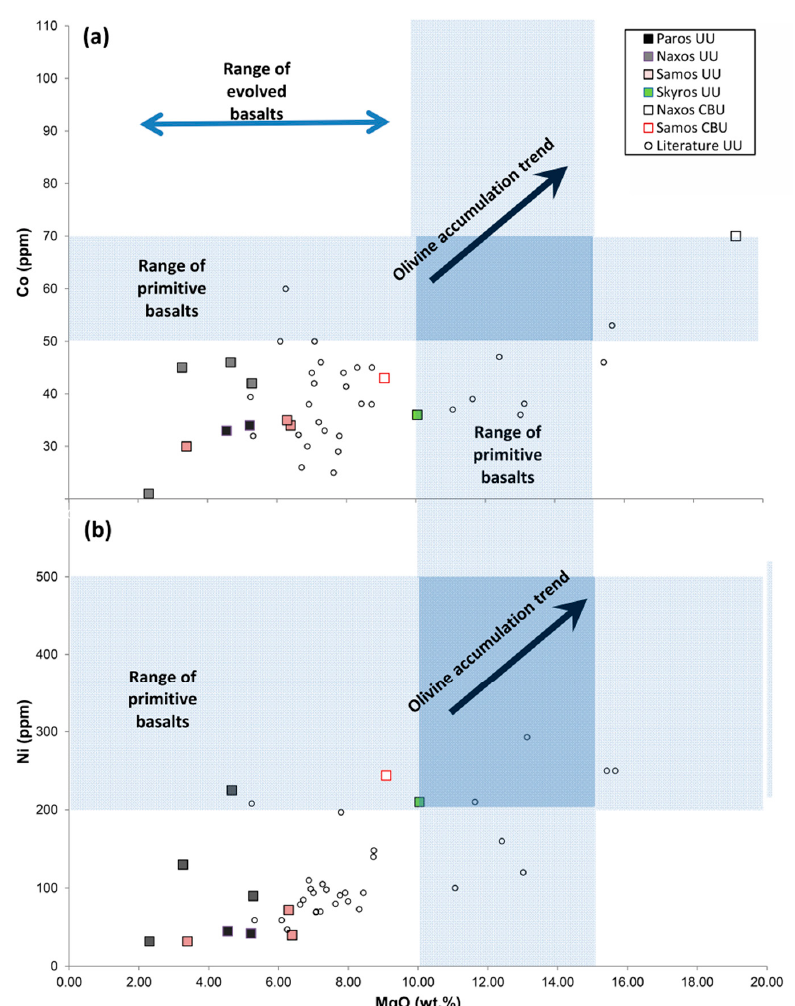
Figure 4. ( a ) MgO vs. Co and ( b ) MgO vs. Ni plot of Aegean metabasites. Upper Unit (UU) ophiolitic metabasites from the literature are also plotted: Ikaria ophiolitic mélange [10]; Tinos ophiolitic upper unit [15] (Mt. Tsiknias). Range expected for magmas in equilibrium with their mantle source: Ni: 200–500 ppm, Co: 50–70 ppm (from [49]). Naxos amphibolites (open squares) plot beyond the compositional range of the Figure 4 a and 4 b .